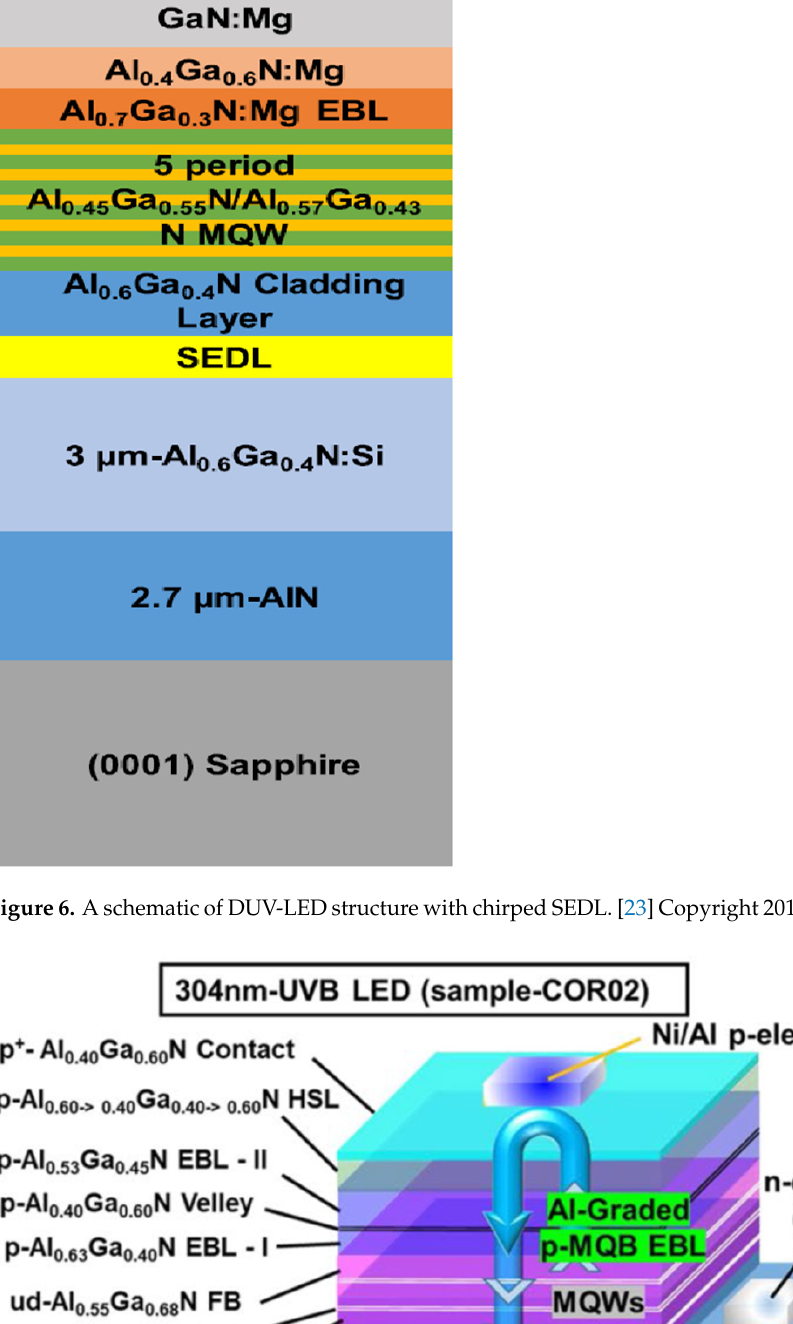
Figure 7. Schematic diagram of 304 nm-band AlGaN-based UVB-LED. [24] Copyright 2022, Springer Nature Publishing. Table 1. A comparison of AlGaN-based UV-LED manufacturing techniques. Group